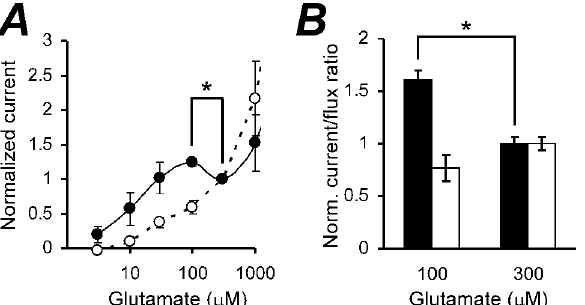
Fig 7. Replacement of intra- and extracellular chloride for D-gluconate eliminated statistically significant decreases in GLT-1 stoichiometric current and the current/flux ratio in 100 – 300 μ M glutamate concentration range. (A) Normalized GLT-1 stoichiometric current glutamate concentration dependences in the presence chloride, E Cl = HP = -70 mV, (solid circles), and in the absence of chloride (open circles). (B) Normalized current/flux ratios in the presence (black bars) and in the absence of chloride (white bars). Flux data are taken from [27]. * - corresponds to p < 0.05.